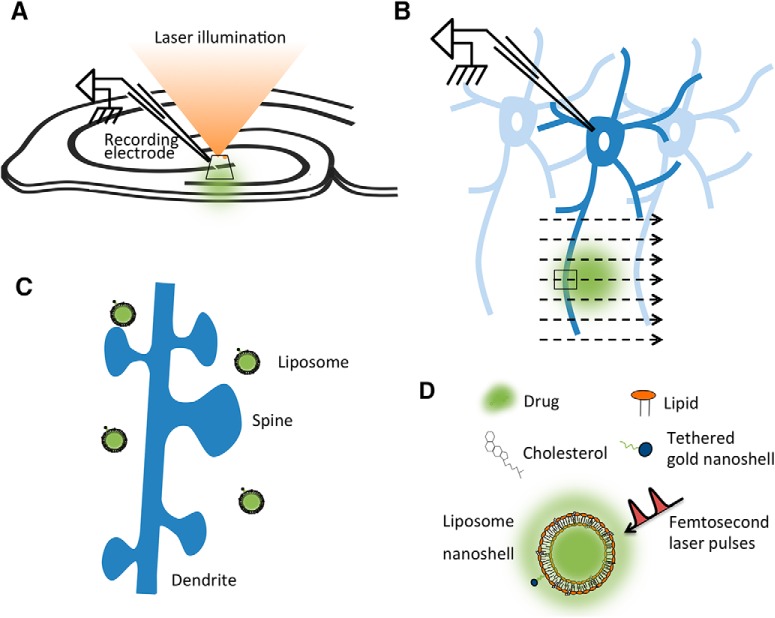
Experimental setup. A, Diagram showing relative positions of recording electrode in hippocampus and laser illumination. Whole-cell recordings were made from pyramidal neurons using patch electrode positions in the liposome-injected region. B, Enlargement of the area shown by the oblique rectangle in A. Laser stimulation was applied to the pyramidal neuron dendritic region by scanning, so that the laser lit small regions one by one, with a laser dwell time of 2 µs. The small rectangle shows the laser scan crossing the dendrite in the region of liposome injection. C, Enlargement of the small rectangle shown in B, showing the location of liposomes in relation to dendrites and dendritic spines. Laser-stimulated liposomes release drugs close to dendritic spines. D, Liposomes were assembled from components, as described previously. Adapted from the study by Nakano et al. (2014) with permission of the authors. Laser spot, Neuronal structures and liposomes not drawn to scale.